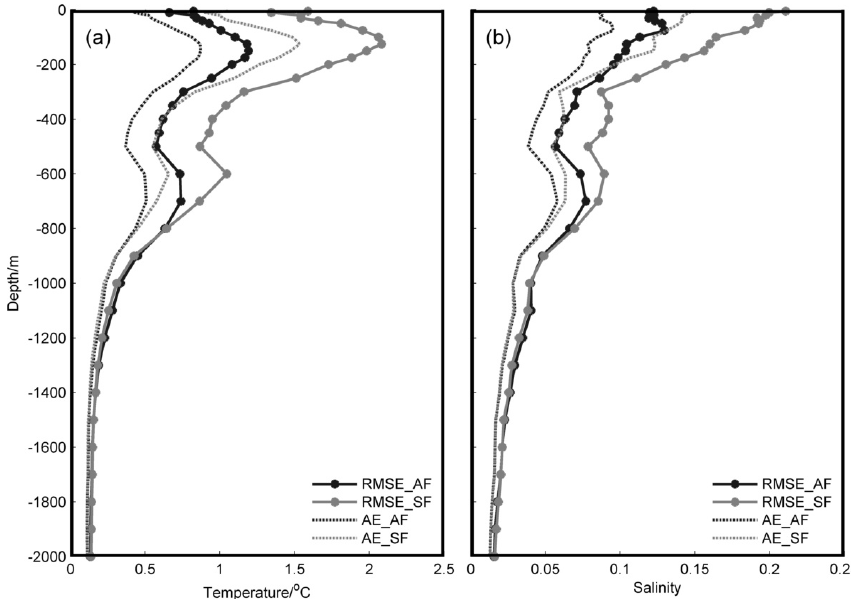
Figure 5. The vertical RMSE and AE for temperature ( a , in ◦ C) and salinity ( b , in psu): the black solid line represents the RMSE of AF, the gray solid line represents the RMSE of SF, the black dotted line represents the AE of AF and the gray dotted line represents the AE of